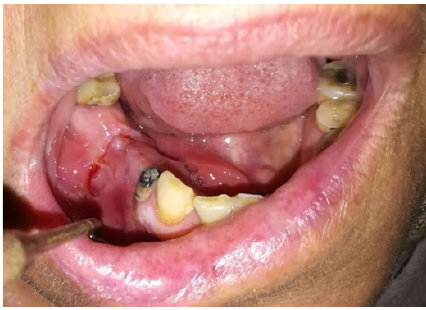
Figure 8. Final tissue volume obtained after 3 months of the alveolar osteogenic distraction surgery.